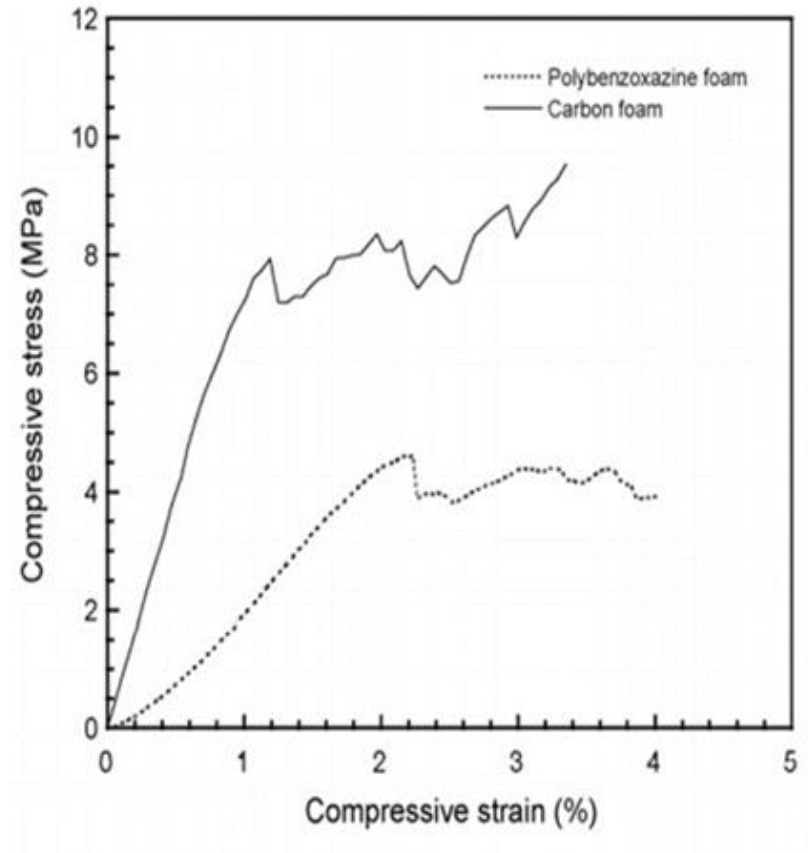
Figure 15. Compressive stress–strain curve of polybenzoxazine foam and carbon foam (reproduced from the work in [59] with permission.)